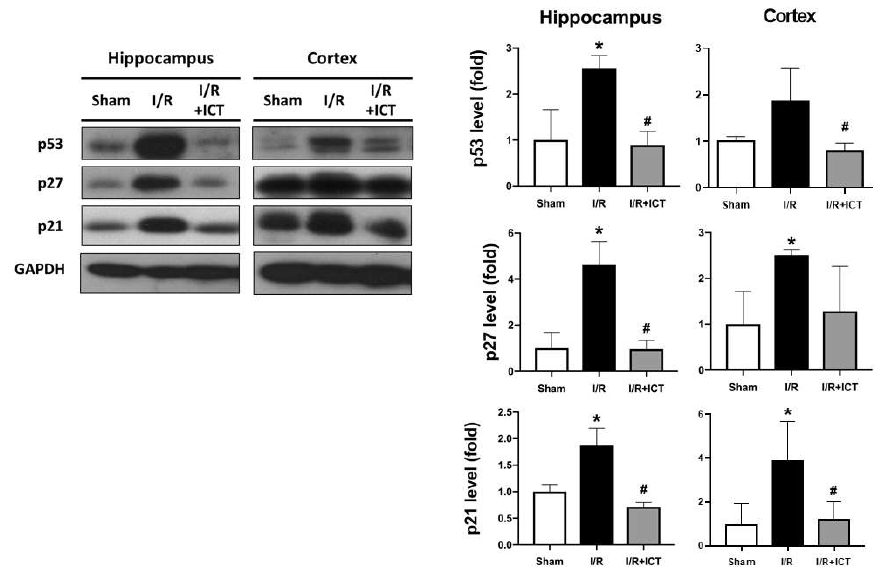
Figure 6. Effects of ICT treatment on cell senescence in mouse brain tissue induced by ischemia– reperfusion. Senescence-associated proteins (p53, p27, and p21) were determined by Western blotting. Data are presented as mean ± SD (n ≥ 4). * p < 0.05 compared with sham group; # p < 0.05 as with I/R group.